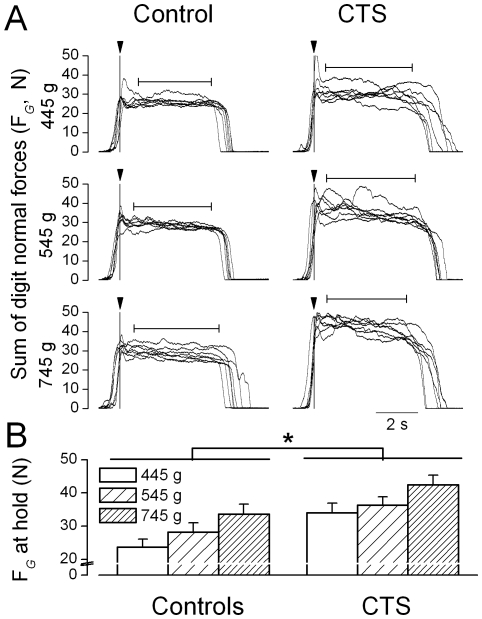
Grip forces during object hold.Panel A shows the time courses of grip force (sum of all digit normal forces, FG) from a representative CTS patient (S7) and his matched control (right and left column, respectively) across a block of trials (n = 7) for each weight condition. Data are aligned relative to object lift onset (vertical line). The horizontal arrows denote the mean duration of object hold averaged across trials. Panel B shows FG during object hold averaged across trials and subjects for the CTS and control group for each weight condition. Vertical error bars denote standard errors. Asterisk indicates statistically significant difference between the two subject groups (P<0.05).